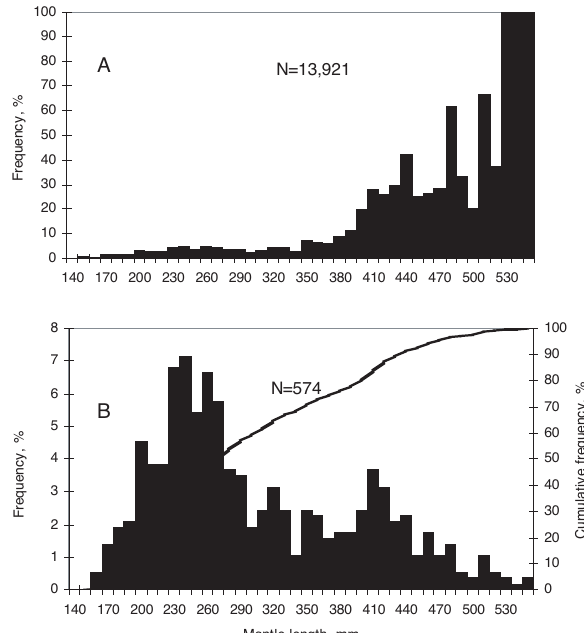
F IG . 2. – Female squid maturation: A, percentage of mature females in the different size groups; B, mature female length frequency (bars, raw data; line, cumulative